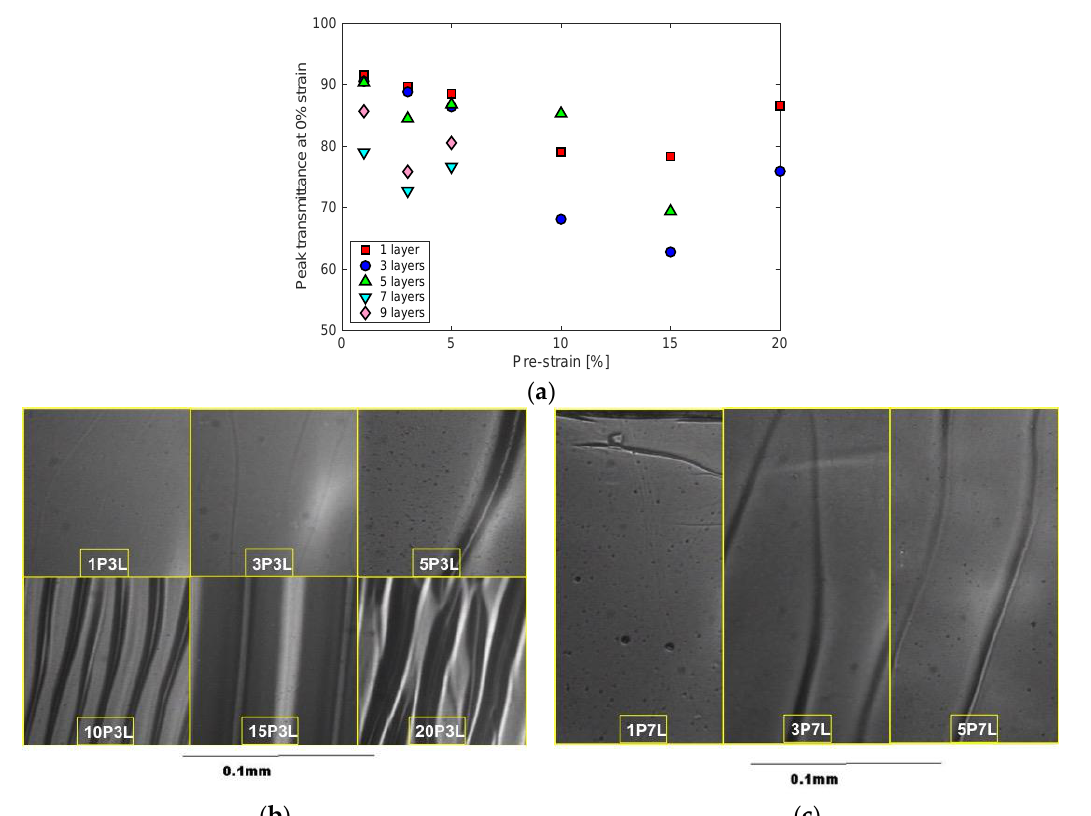
Figure 6. ( a ) Peak transmittances at 0% strain are shown with pre-strain that was applied when fabricating corrugated PEDOT:PSS thin film specimens. Optical microscopic images are shown for the corrugated thin film specimens having ( b ) 3 layers and ( c ) 7 layers.